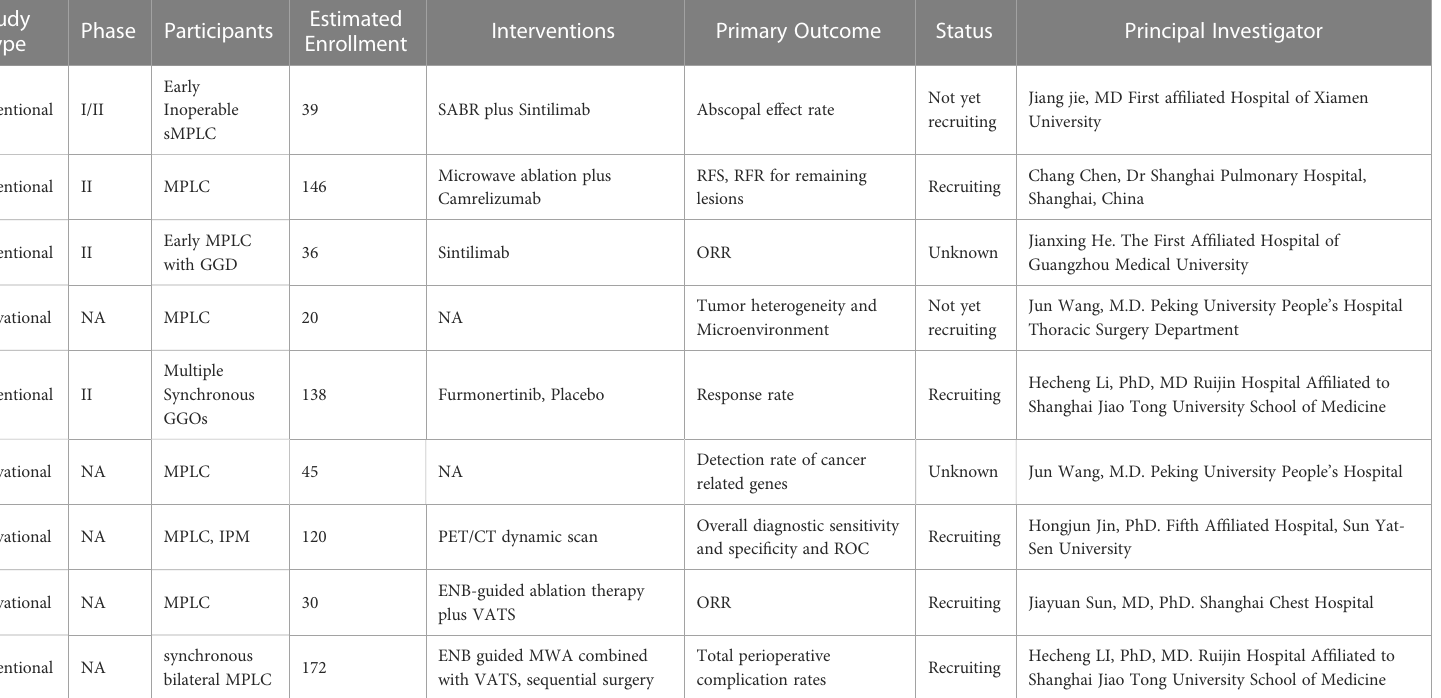
TABLE 3 Registered clinical trials about